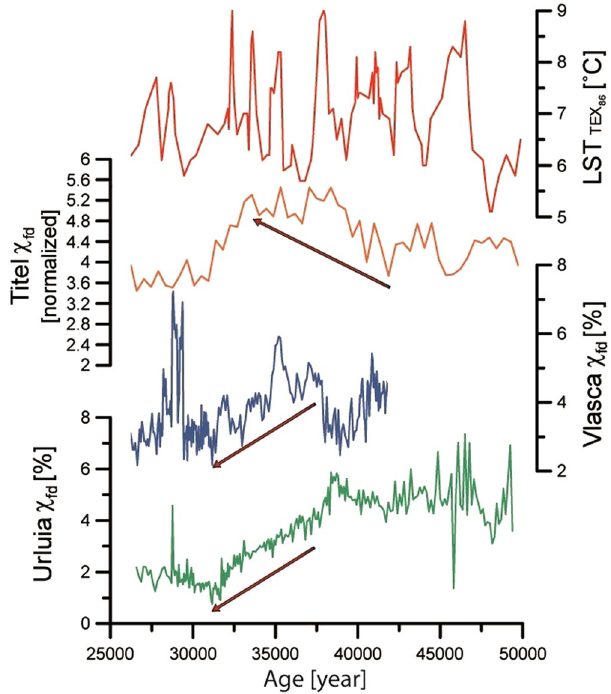
Figure 3. Direct comparison between χ fd record from Urluia (green line) and Vlasca (blue line), χ fd from Titel loess-palaeosol sequence 37 (orange line; Middle Danube Basin) and their comparison with the mean annual lake surface temperature (LST; red line) of the Black Sea 26 over 25,000–50,000 years